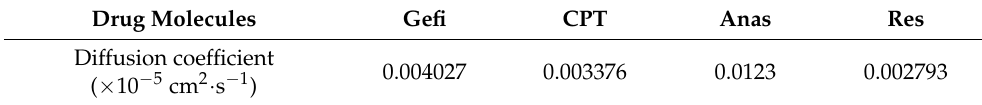
Table 1. Self-diffusion coefficients of different drugs adsorbed on graphene surface.